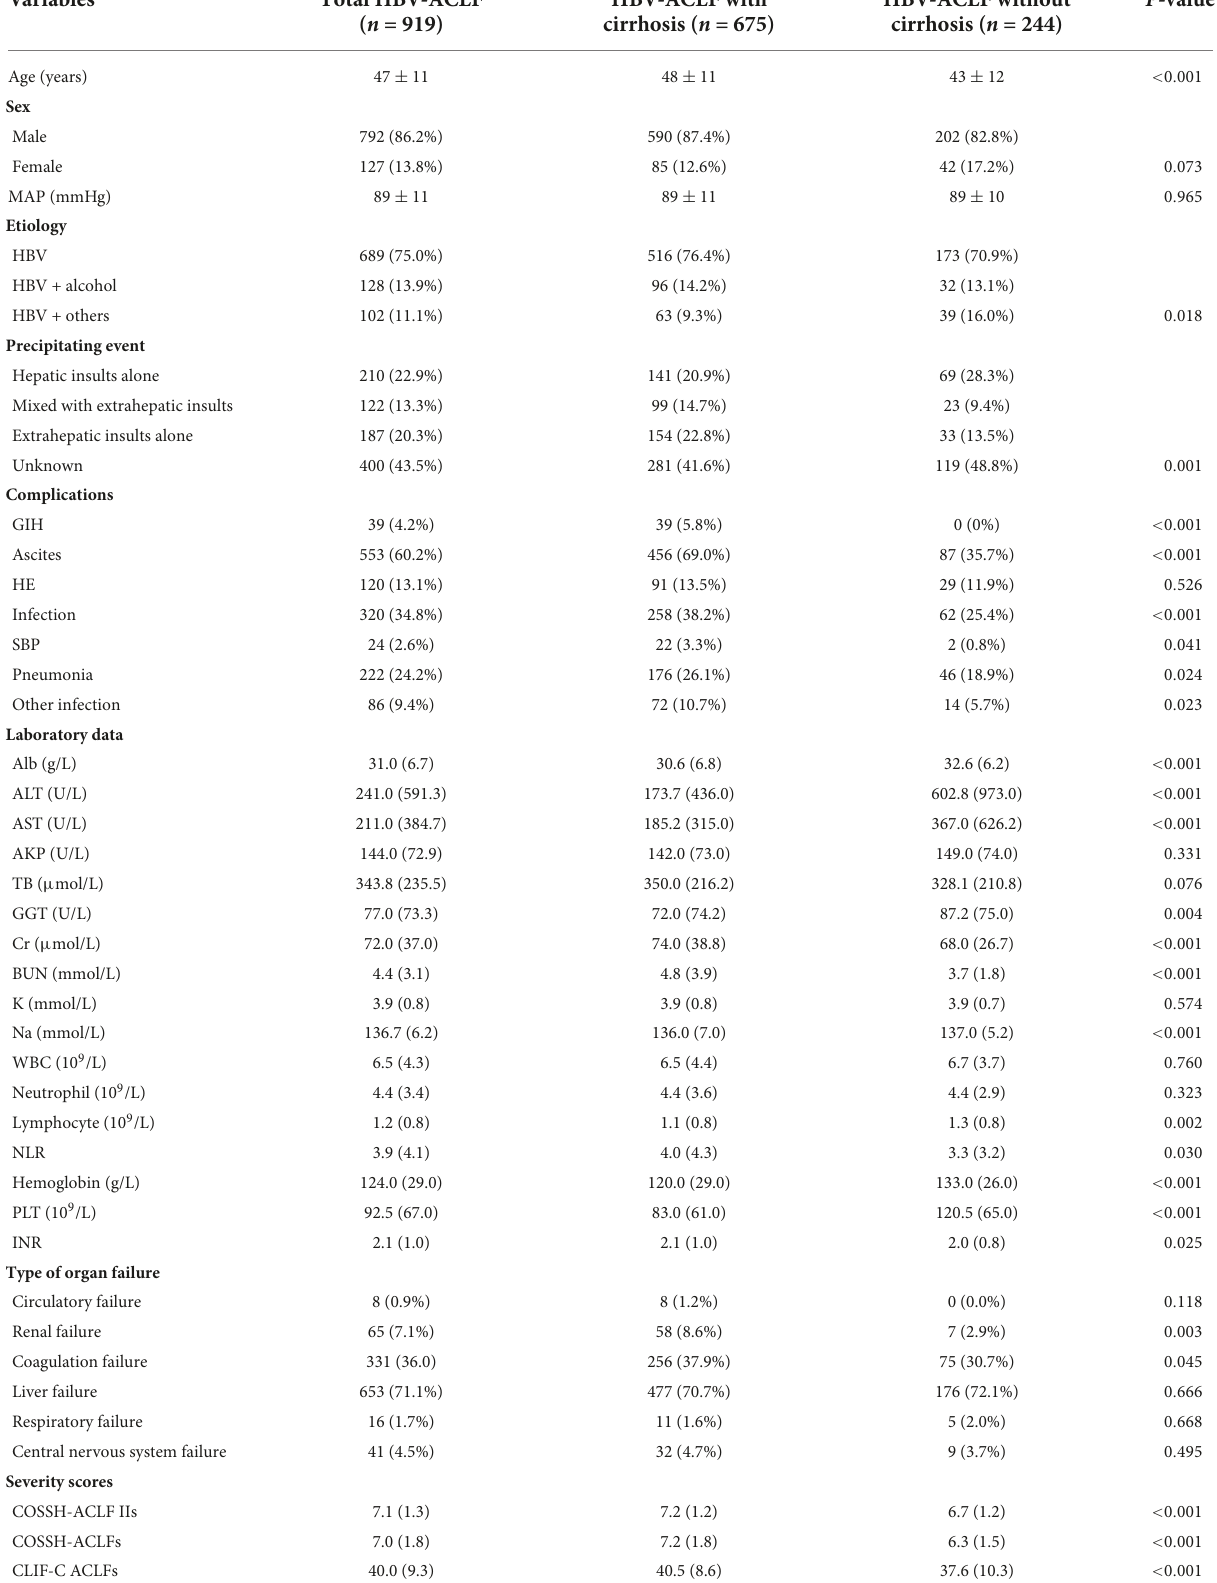
TABLE 1 Patient characteristics at